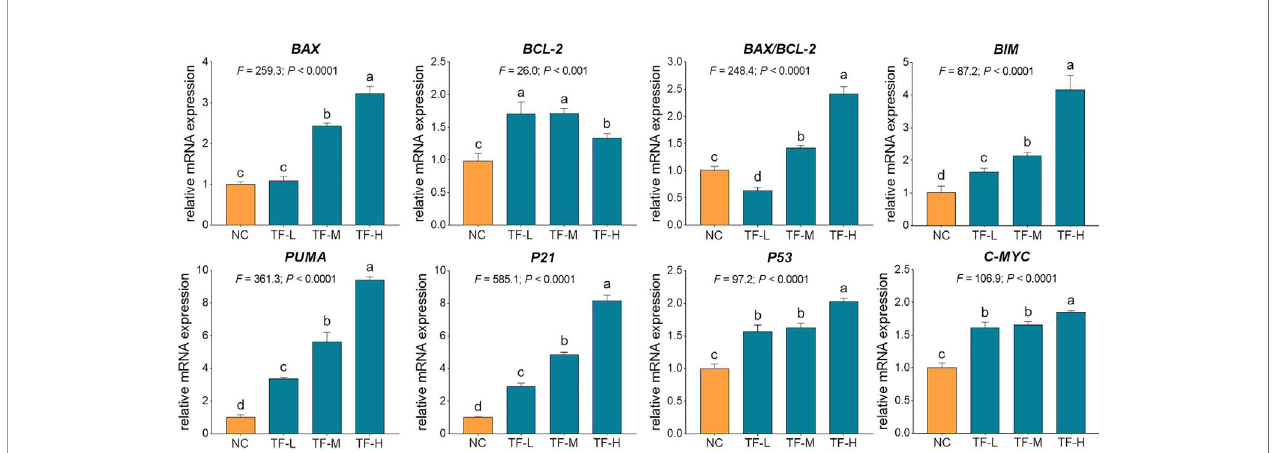
FIGURE 4 | Relative mRNA expression of thea fl avin (TF)-targeted genes in A375 cells after 24 h treatment. By means of Fisher ’ s least signi fi cant difference (LSD) multiple comparisons, data (mean ± SD) with same lowercase letter (a vs. a; b vs. b; c vs. c) indicate no signi fi cant difference between each other, while data with different letters (a vs. b vs. c vs. d) indicate signi fi cant difference with each